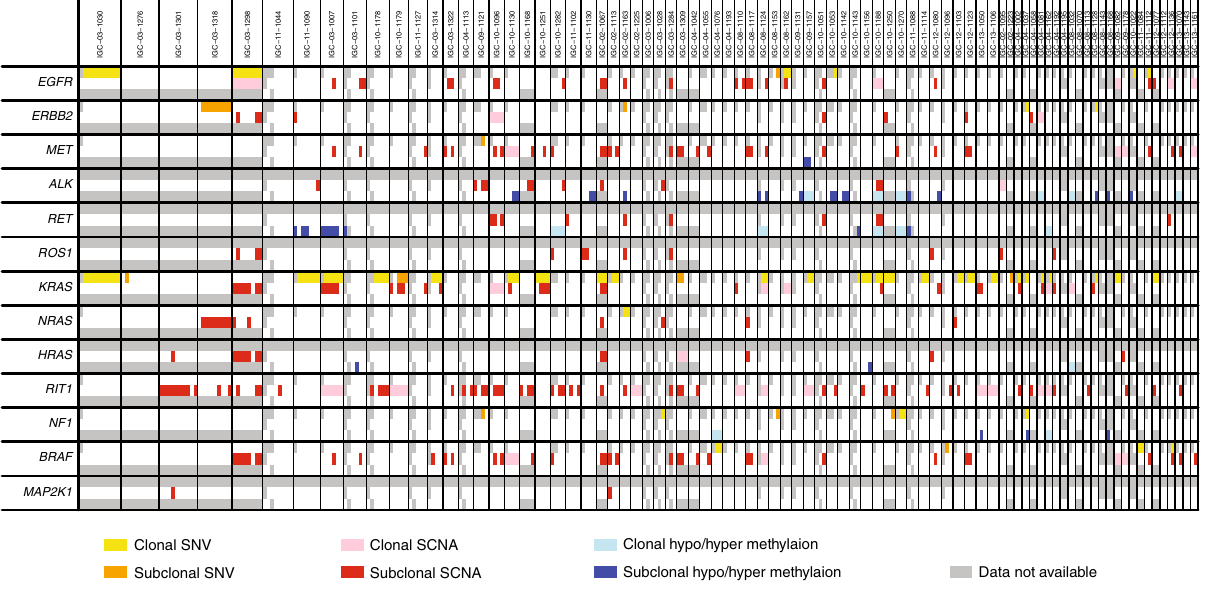
Fig. 5 Intratumor heterogeneity of genomic and epigenomic alterations of 13 cancer driver genes in RTK/RAS/RAF pathway. Shown are public and private SNVs, SCNAs, and DNA methylation alterations in 84 subjects. SNVs, SCNAs, and DNA methylation alterations are indicated by yellow/orange, red, and blue, respectively. Clonal and subclonal events are indicated by light and dark shades, Methods Patients and multi-region tumor samples . The current work includes 84 patients with LUAD from the EAGLE study, a population-based case-control study con- ducted in Italy between 2002 and 2005 (refs. 12,21,22 ). Samples were snap-frozen in liquid nitrogen within 20 min of surgical resection and the precise site of tissue